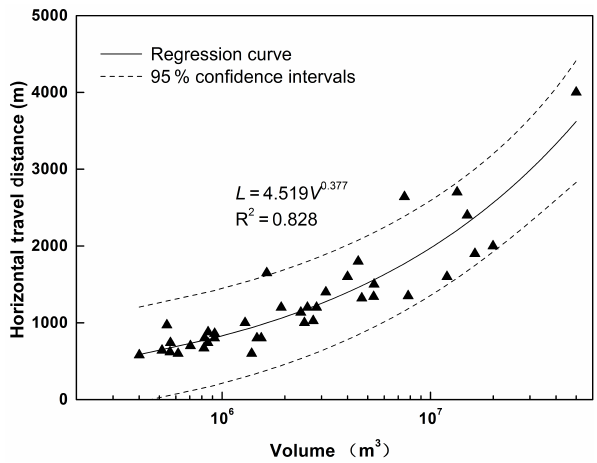
Figure 6. Relationship between horizontal travel distance and vol- ume of channelized rock avalanches.